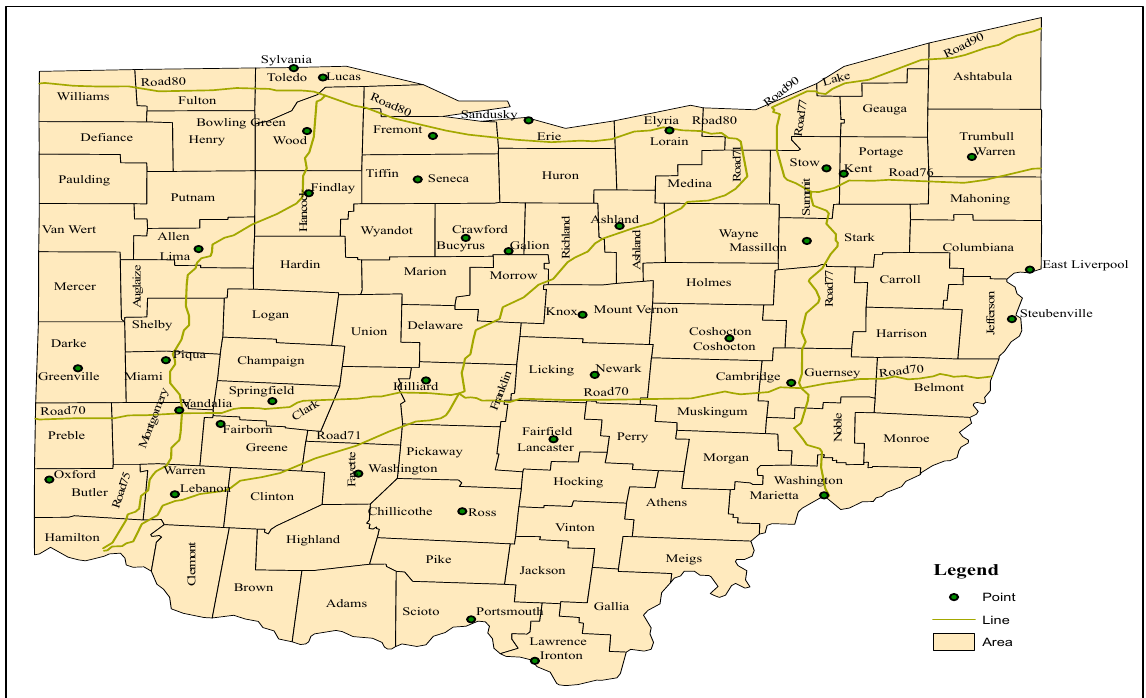
Figure 12. Result of the third dataset using the proposed algorithm.